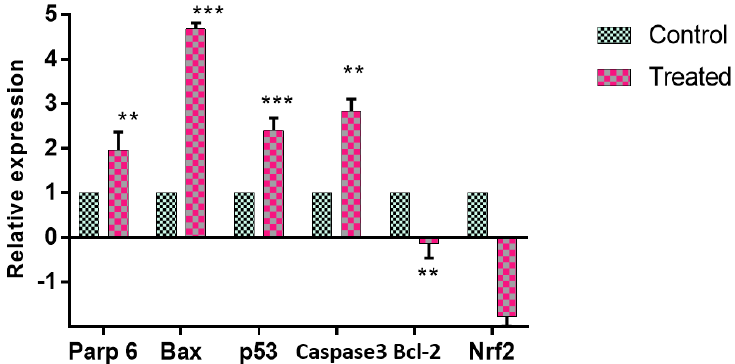
Figure 8. The effect of GMG-ITC on mRNA expression. Values represent fold changes between control and treatment groups. Data are expressed as mean ± SD; ns: non-significant compared to the control, ** p < 0.05; *** p < 0.001.